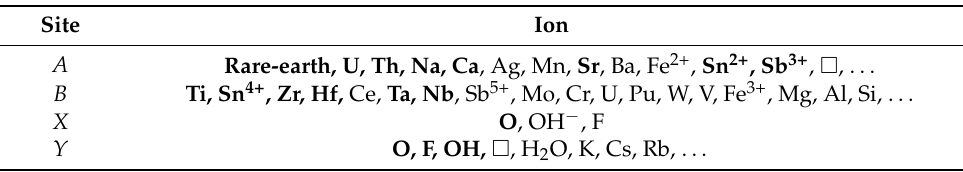
Table 1. Ion substitute eligibility for the various sites of the pyrochlore supergroup [6,34–36]. Site Ion A Rare-earth, U, Th, Na, Ca , Ag, Mn, Sr , Ba, Fe 2+ , Sn 2+ , Sb 3+ , (cid:3) , . . .